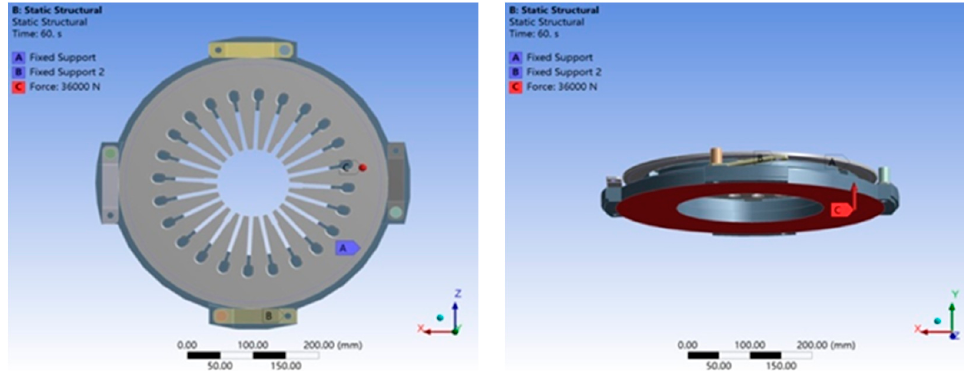
Figure 3. Constraint 1.